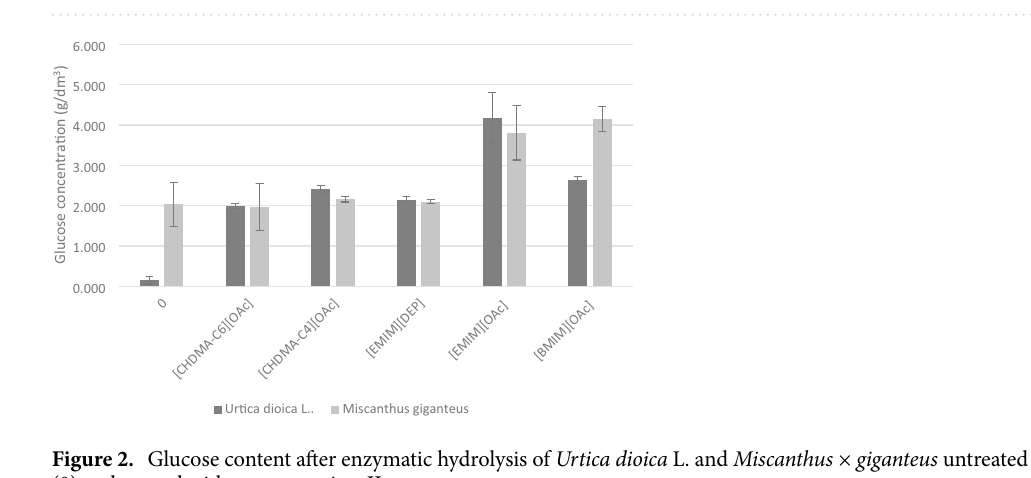
Figure 1. Scanning electron microscopic images of Urtica dioica L.: ( a ) untreated; ( b ) after pretreatment with [bmim][OAc]; ( c ) after pretreatment with [emim][OAc].